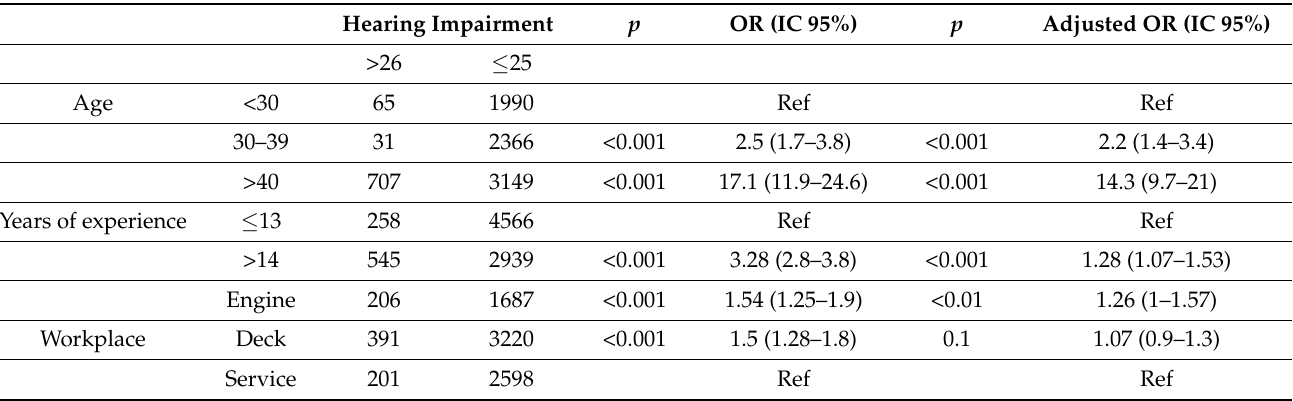
Table 4. Univariate and multivariate analysis adjusted for co-founders including, age, experience, and workplaces of